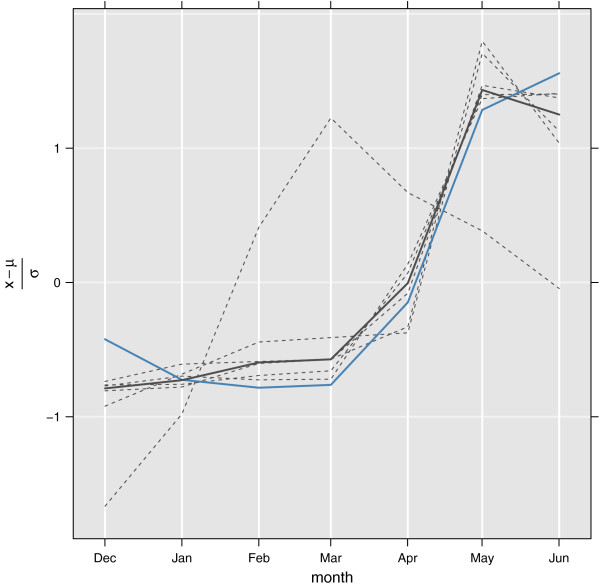
Scaled variations over time of six locations (dashed grey line), and the median seasonality (solid grey line) in Central Ethiopia [26] (data from KEN11). Blue solid line shows modelled relative seasonality in the same area.